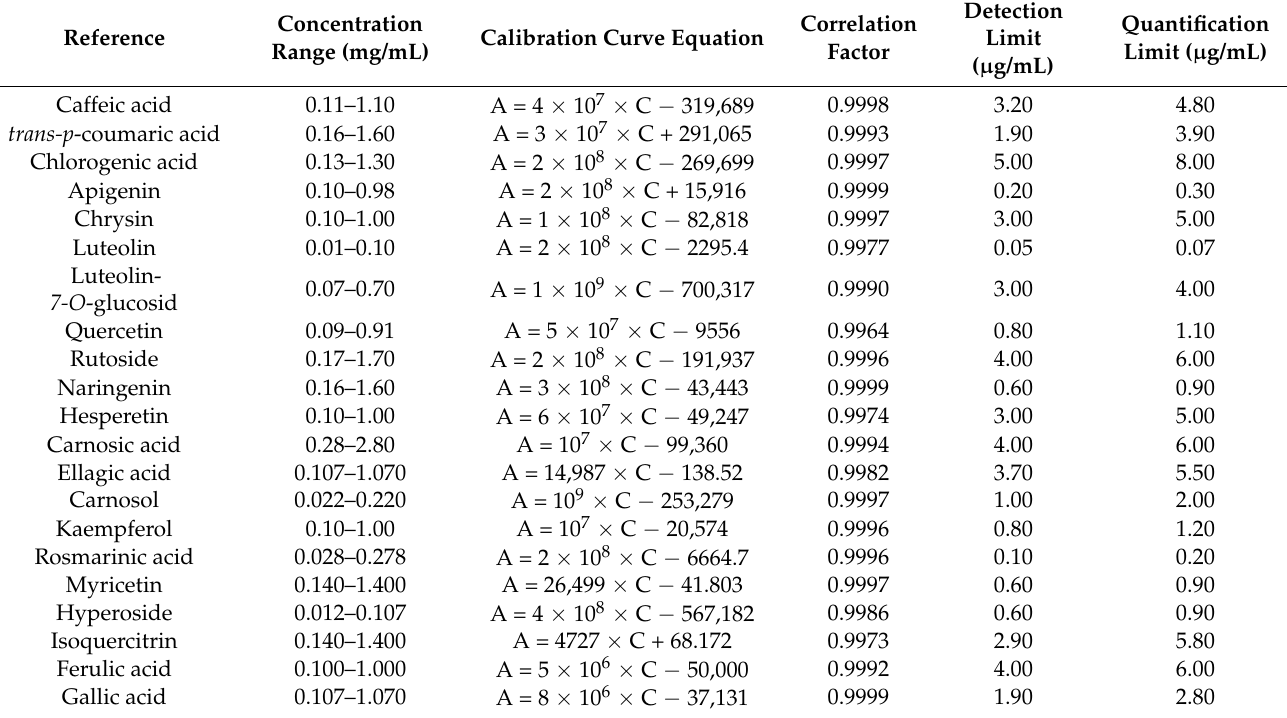
Table 8. LC/MS- The quantification parameters of the